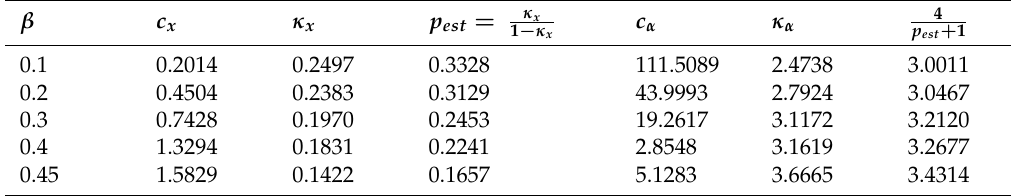
Table 1. Numerically computed results for discrepancy principle expressed in Equation (33) and x † ( t ) = ct − β ( 0 < t ≤ 1 ) yielding by regression multipliers and exponents of regularization error expressed in Equation (36) and α -rates expressed in Equation (37) for various values 0 < β < 0.5. β c x κ